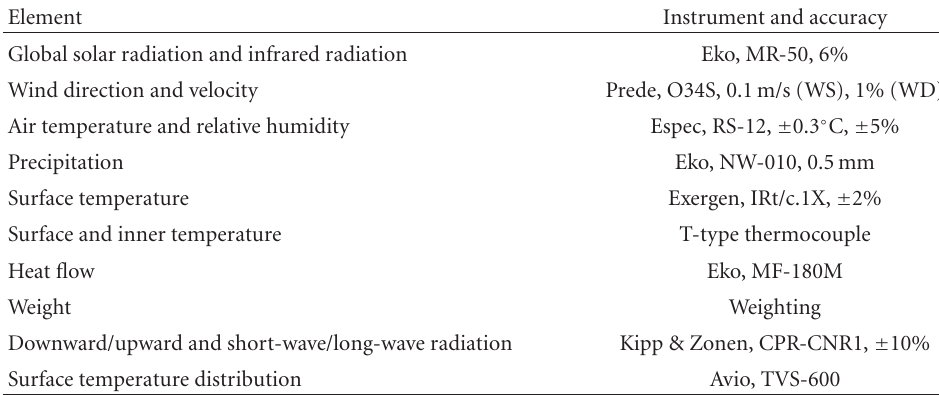
Table 2: Outline of observation